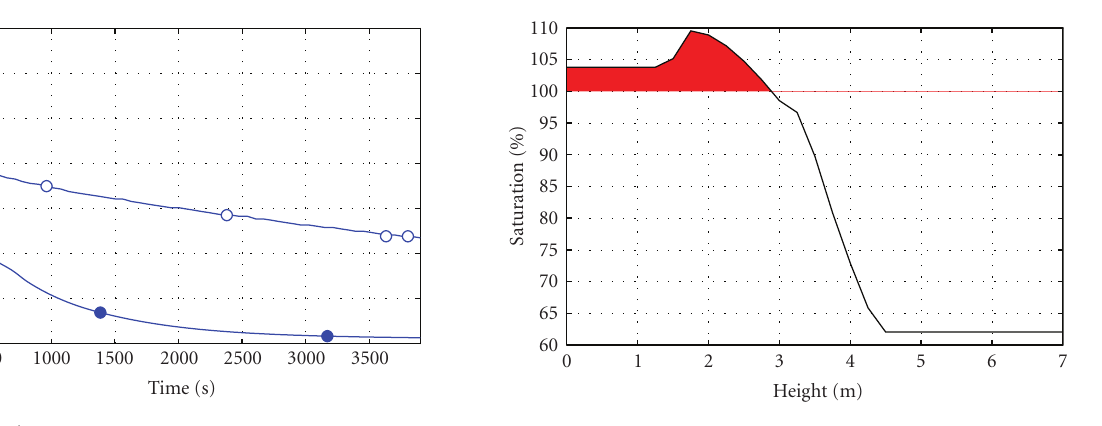
Figure 6: Relative humidity obtained with conditions from part B specification.